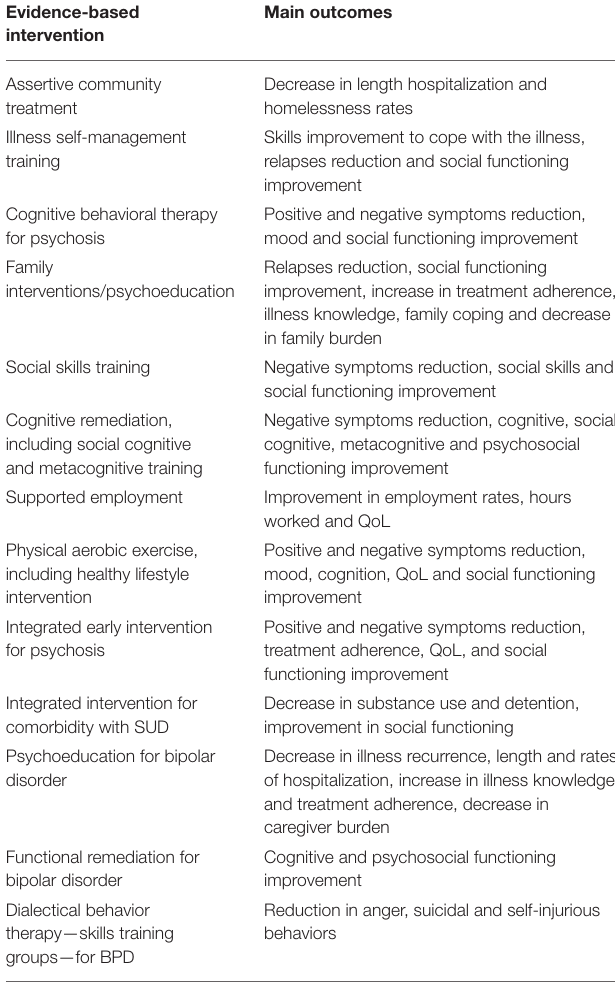
TABLE 1 | Evidence-based psychiatric rehabilitation interventions for